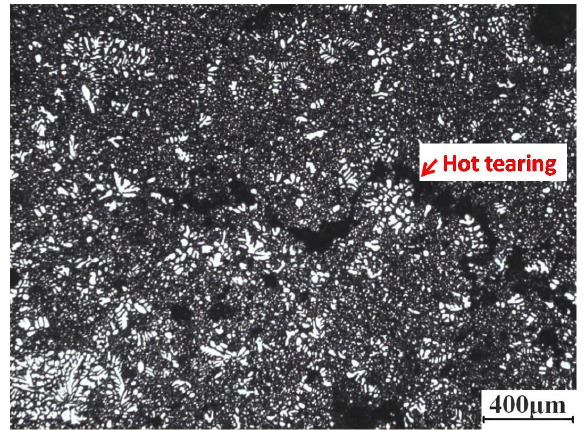
Figure 15. Microstructure of hot tearing in AM60 sample produced by liquid die casting.